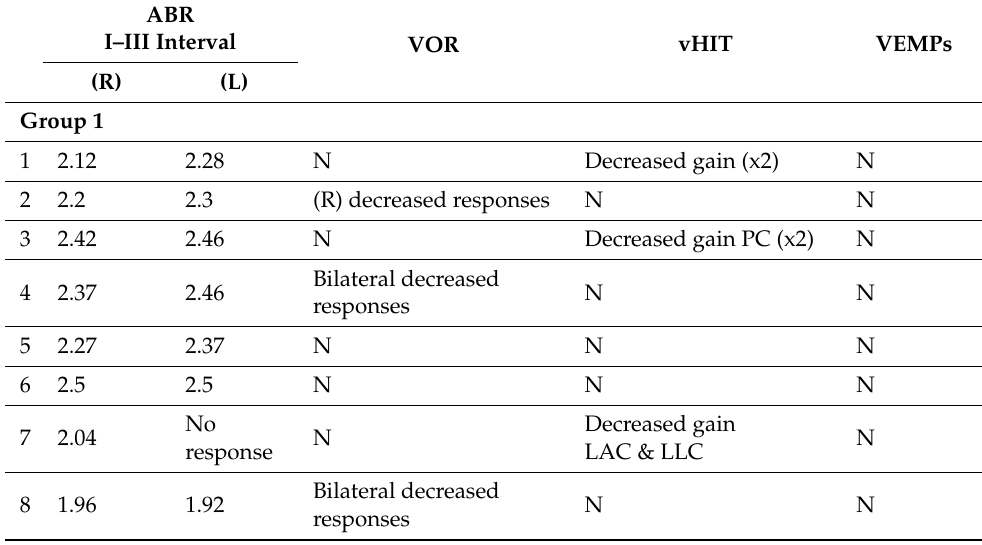
Table 2. Audio vestibular evaluation for Groups 1, 2, and 3. Abbreviations: ABR (auditory brain- stem response), AC (anterior canal), L (left), LC (lateral canal), PC (posterior canal), R (right), VEMPs (vestibular evoked myogenic potentials), vHIT (video head impulse test) and VOR (vestibulo- ocular